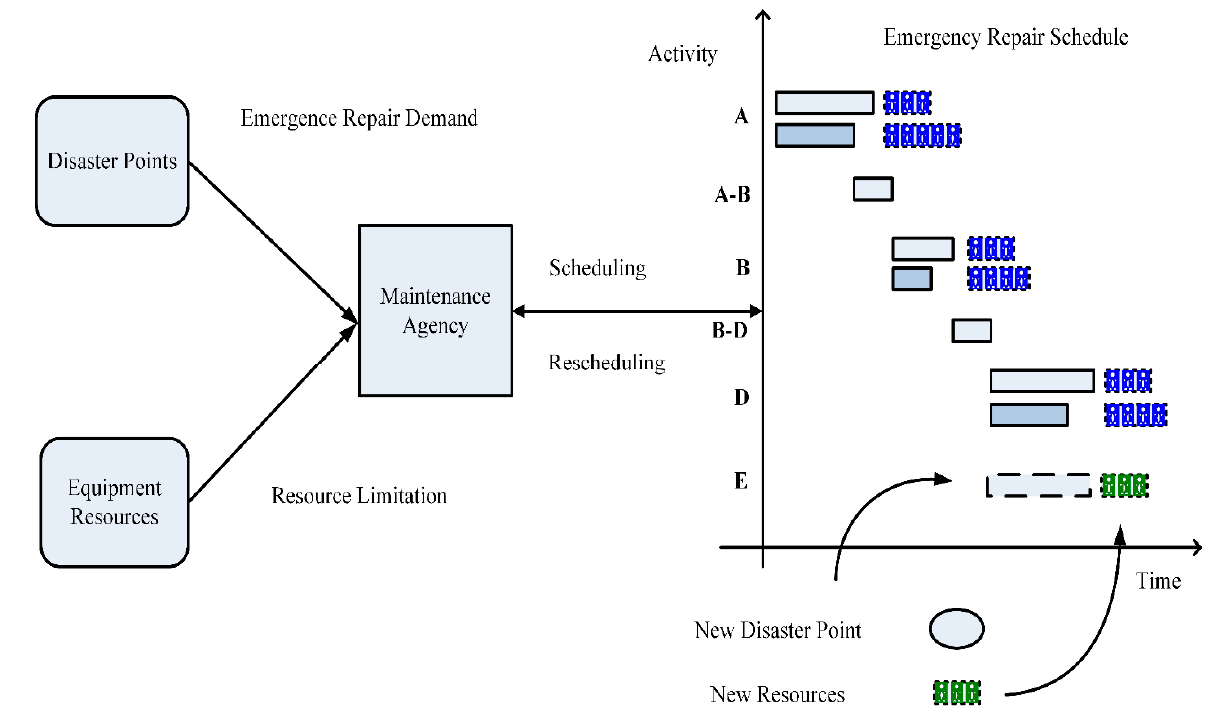
Figure 1. Conceptual diagram of emergency repair scheduling model.